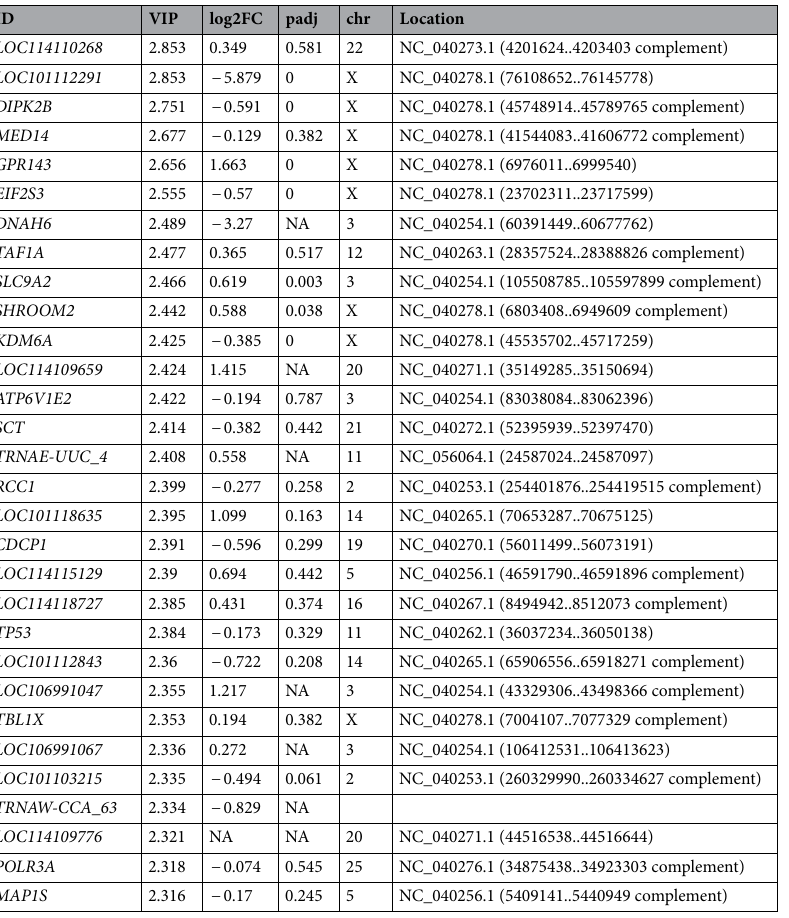
Table 3. Top 30 sex-specific differences in potential coding biomarkers in LV tissue of control sheep. Top 30 Coding RNA biomarkers comparing control female and male-fetal cardiac tissue based on variable importance in Projection values (VIP) along with the corresponding log2FC and padj values obtained from DESeq2 analysis for the same determinants are represented. ncRNA is highlighted in